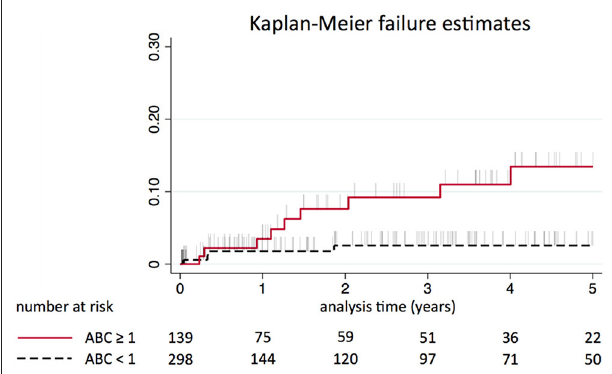
FIGURE 1 | Kaplan-Meier estimated event rate for patients labeled as moderate risk by the CHA 2 DS 2 -VASc score stratified by ABC-stroke risk classes ( ≥ 1 vs. < 1% risk of stroke per 1